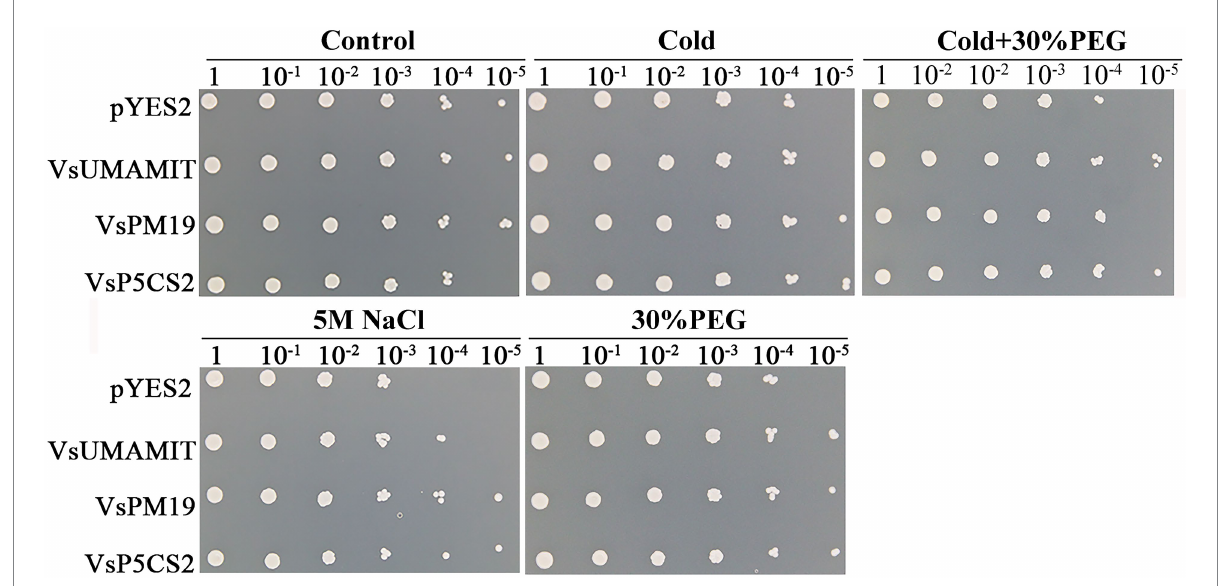
FIGURE 9 The expression of pYES2, pYES2-VsUMAMIT, pYES2-VsPM19, and pYES2-VsP5CS2 in INVSc1 cells induced under cold ( − 20 ° C), 5 M NaCl, 30% PEG, and cold + 30% PEG